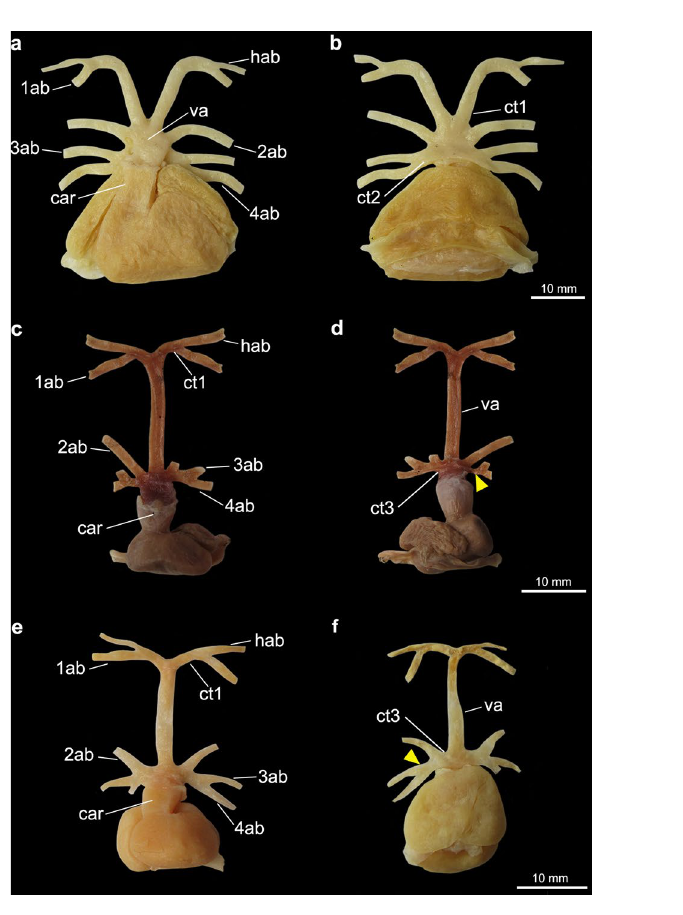
Figure 3. Heart and afferent branchial arteries in Torpediniformes. ( a ) ventral and ( b ) dorsal views of Tetronarce puelcha ; ( c ) ventral and ( d ) dorsal views of Narcine brasiliensis ; ( e ) ventral and ( f ) dorsal views of Heteronarce sp. 1ab-4ab 1st-4th afferent branchial arteries; car conus arteriosus ; ct1 common trunk from the ventral aorta to the hyoidean and first afferent branchial arteries; ct2 common trunk from the ventral aorta to the two posteriormost afferent branchial arteries; ct3 common trunk from the ventral aorta to the three posteriormost afferent branchial arteries; hab hyoidean afferent branchial artery; va ventral aorta. Yellow triangles point to the common vessel that originates the third and fourth afferent branchial